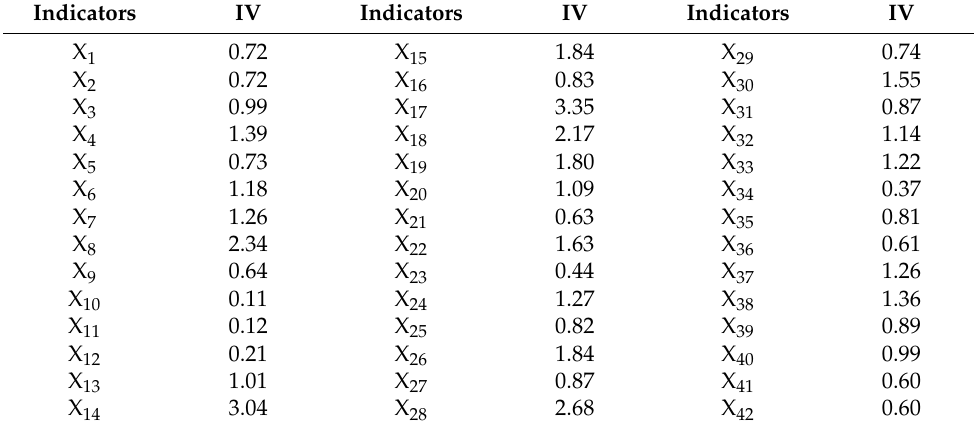
Table 2. Information Value Index of financial indicator of analyzed enterprises.